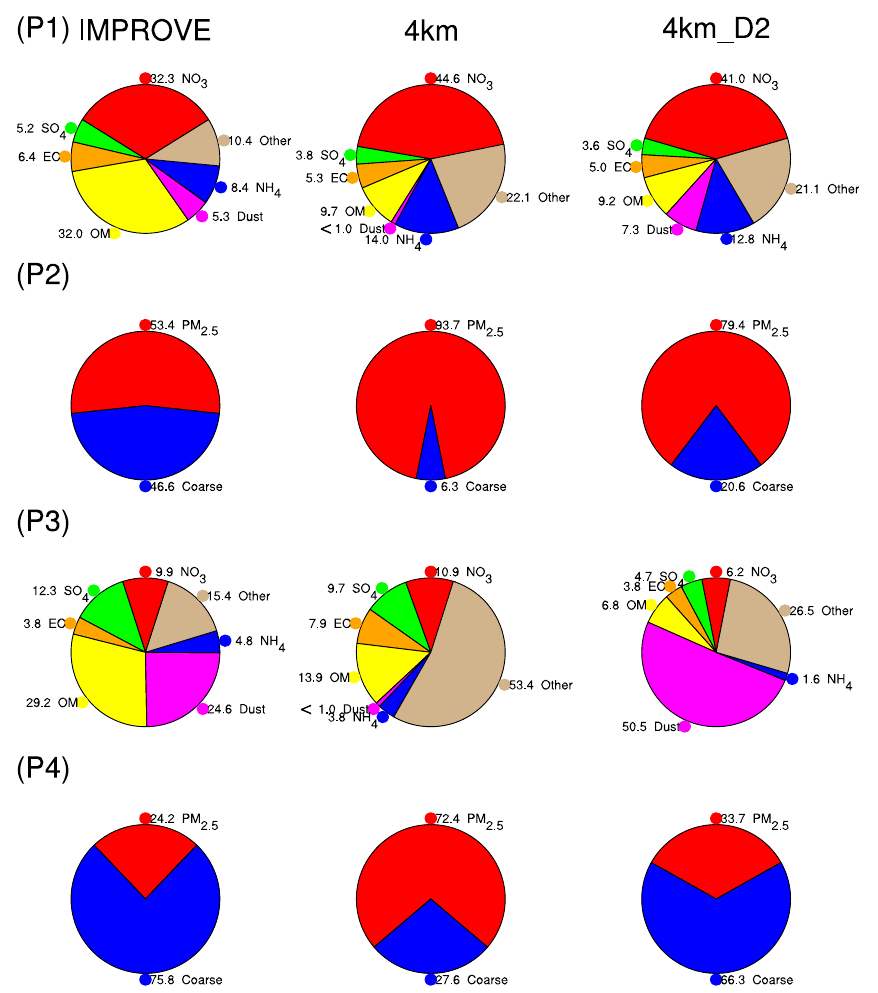
Figure 10. Relative contribution (%) of aerosol species from IMPROVE and the WRF-Chem (4km and 4km_D2) simulations at Fresno, CA, in WY2013. (Panel 1) Contribution to PM 2 . 5 in the cold season; (panel 2) relative contribution of PM 2 . 5 and coarse mass (CM) to PM 10 in the cold season; (panel 3) same as panel 1 but in the warm season; (panel 4) same as Panel 2 but in the warm season. “Other” refers to the difference of PM 2 . 5 total mass and specified PM 2 . 5 (NO 3 , NH 4 , OM, EC, SO 4 and dust).